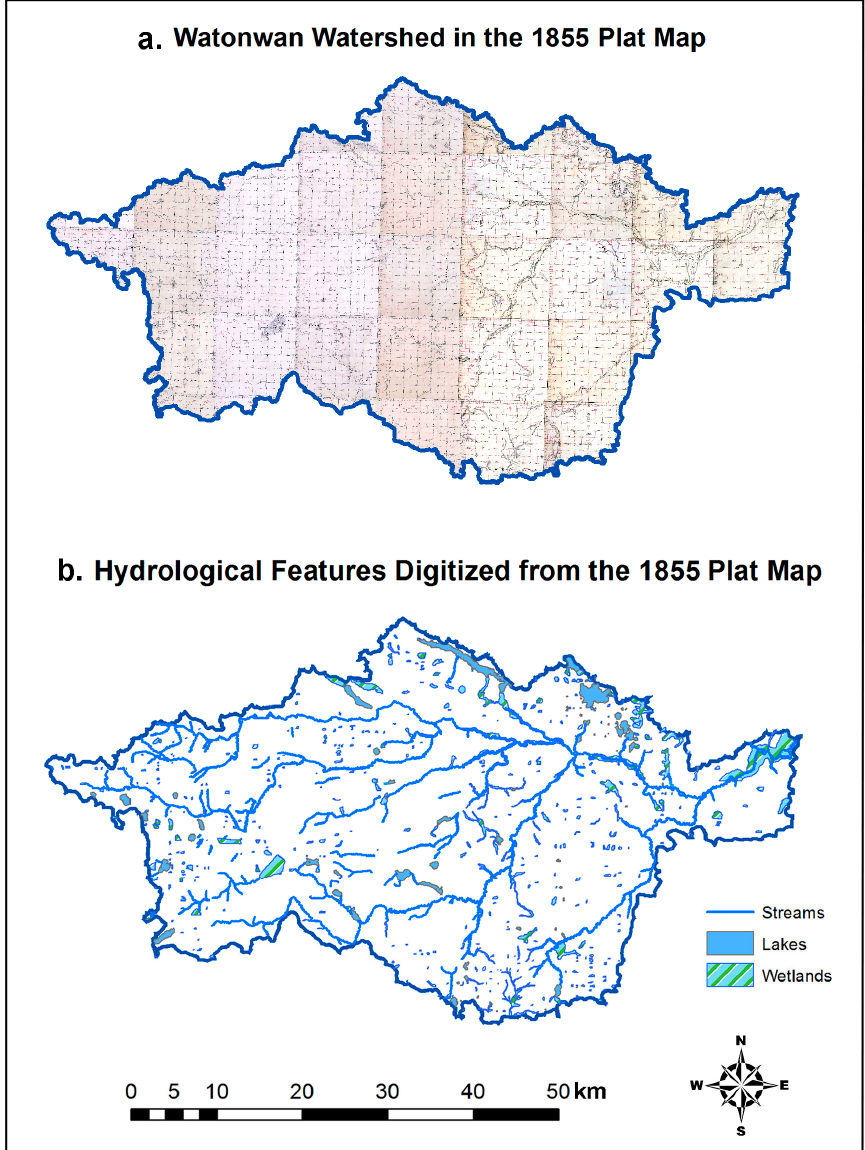
Figure 5. The 1855 plat map ( a ) and the hydrological features digitized from the plat map ( b ).